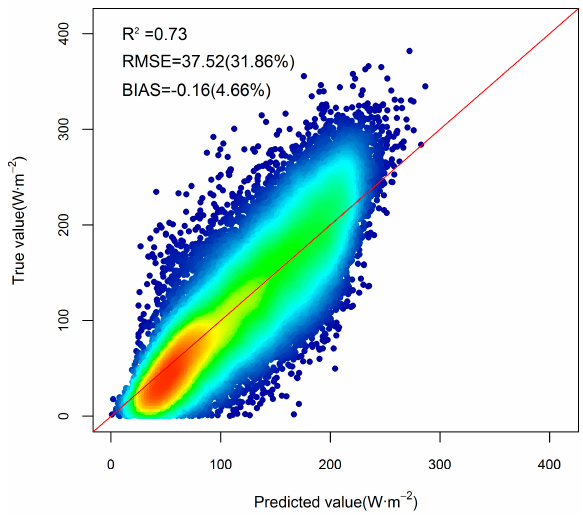
Figure 8. Validation results of the estimated daily DSR based on the GBRT model without considering AVHRR channels 4 and 5 as the input variables under cloudy sky conditions. The number in the parentheses is the percent bias or RMSE value.